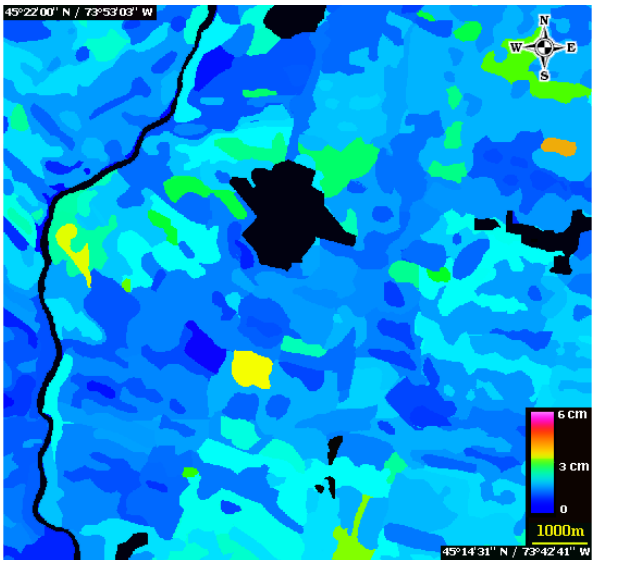
Fig. 13. rms height map in homogeneous zone scale.